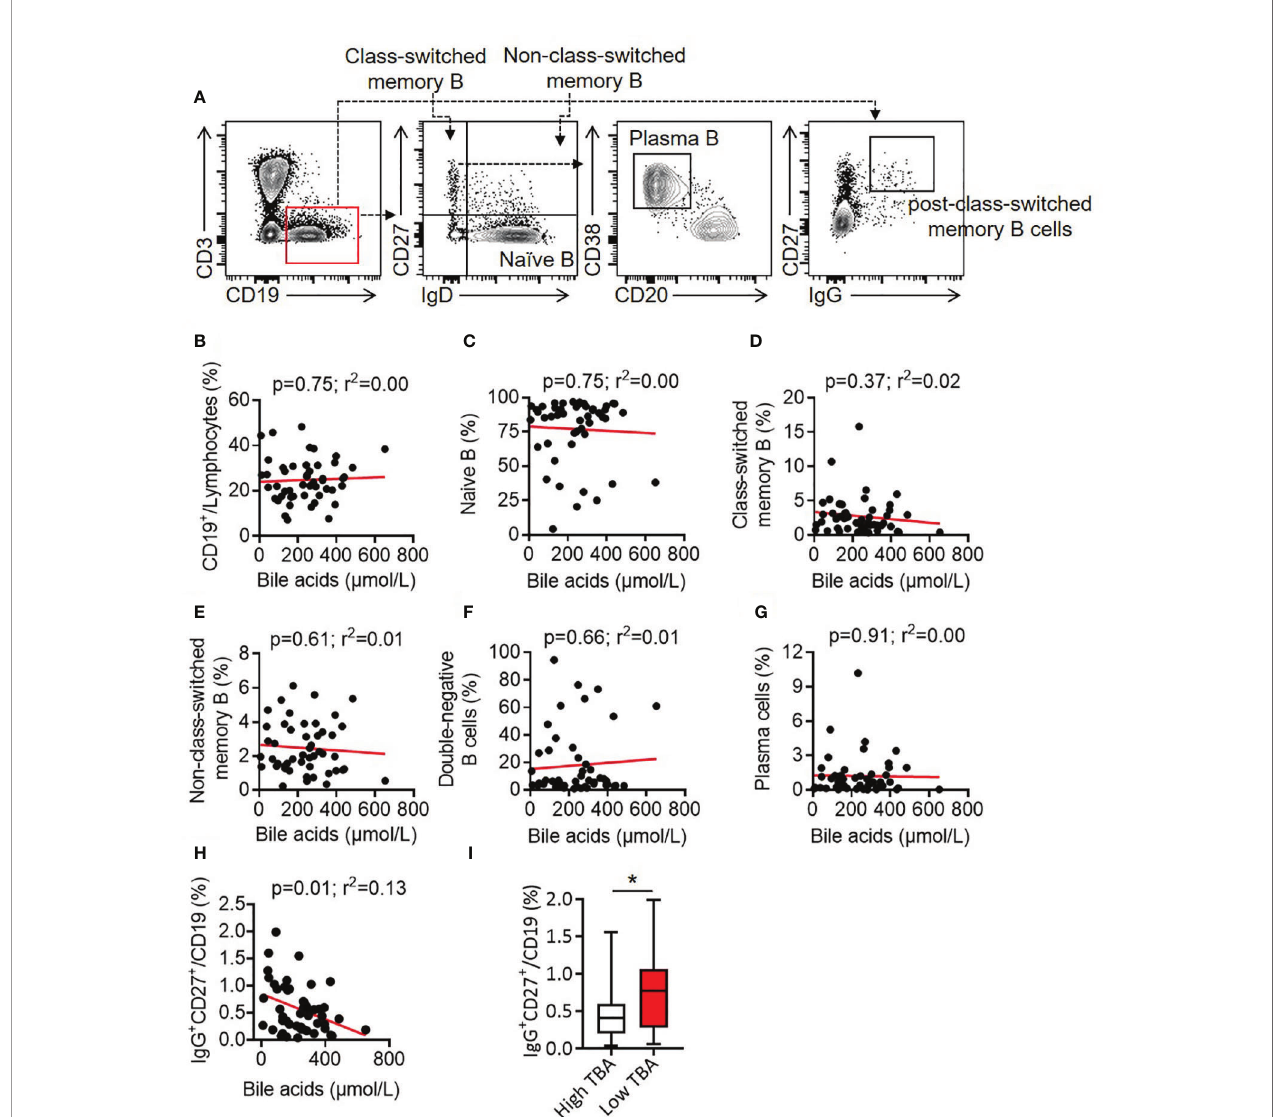
FIGURE 4 | Correlation between bile acid levels and B cells in BA children. (A) Representative FACS dots of B cells (CD3 - CD19 + ), naive B cells (CD3 - CD19 + IgD + CD27 - ), class-switched memory B cells (CD3 - CD19 + IgD - CD27 + ), non-class-switched memory B cells (CD3 - CD19 + IgD + CD27 + ), double-negative memory B cells (CD3 - CD19 + IgD - CD27 - ), post-class-switched memory B cells (CD19 + CD27 + IgG + ) and plasma cells (CD3 - CD19 + IgD - CD27 + IgM - CD20 - CD38 + ) in the PBMCs of patients with BA. (B – H) Correlation between bile acid levels and B cells (B) , naive B cells (C) , class-switched memory B cells (D) , non-class-switched memory B cells (E) , double-negative memory B cells (F) , plasma cells (G) and post-class-switched memory B cells (H) in the PBMCs of patients with BA. (I) Proportion of CD19 + CD27 + IgG + post-class- switched memory B cells between high TBA and low TBA groups * means p < 0.05